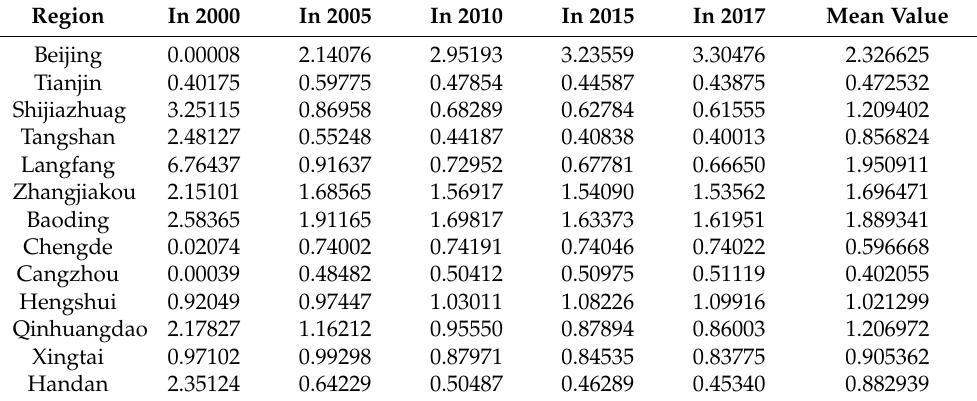
Table 3. Location entropy of electricity, heat production, and supply